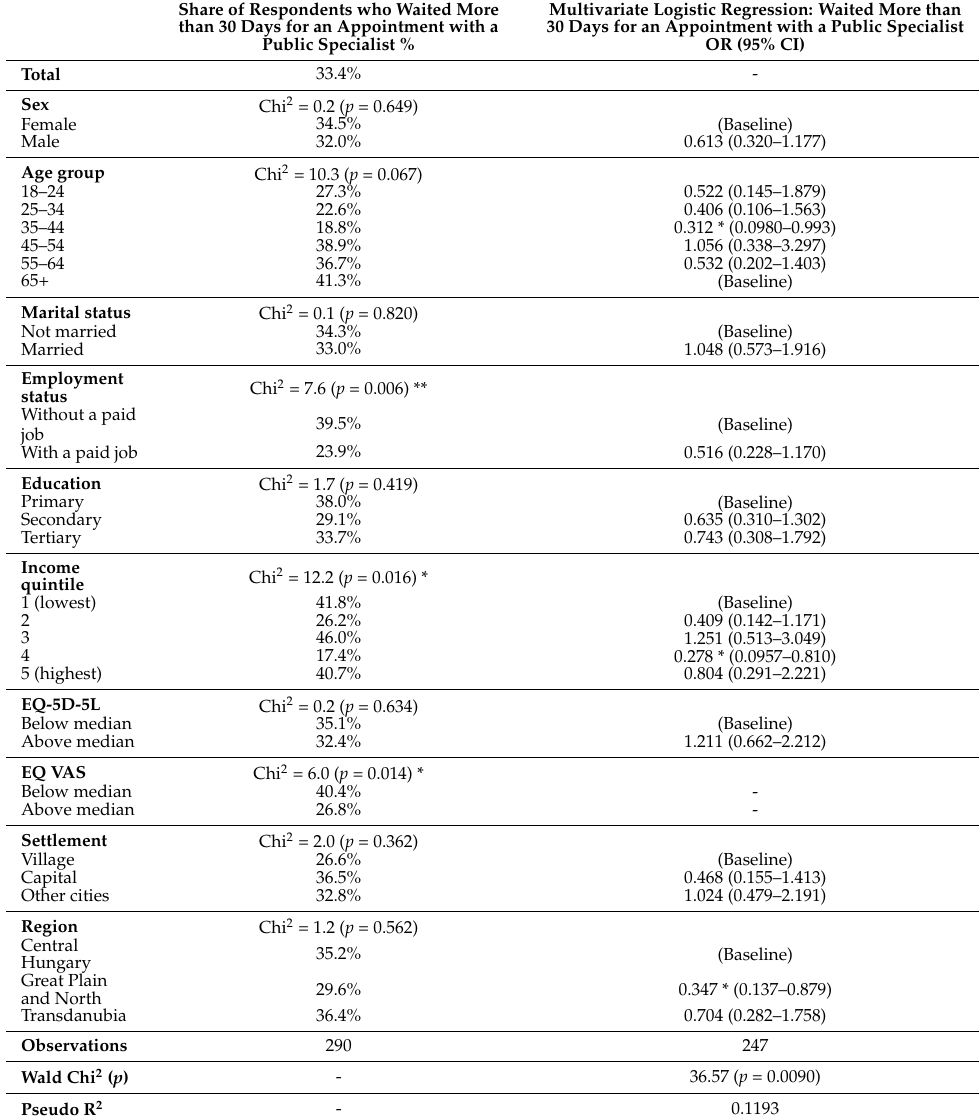
Table 3. Share of respondents who waited more than 30 days for an appointment with a public specialist and multivariate logistic regression